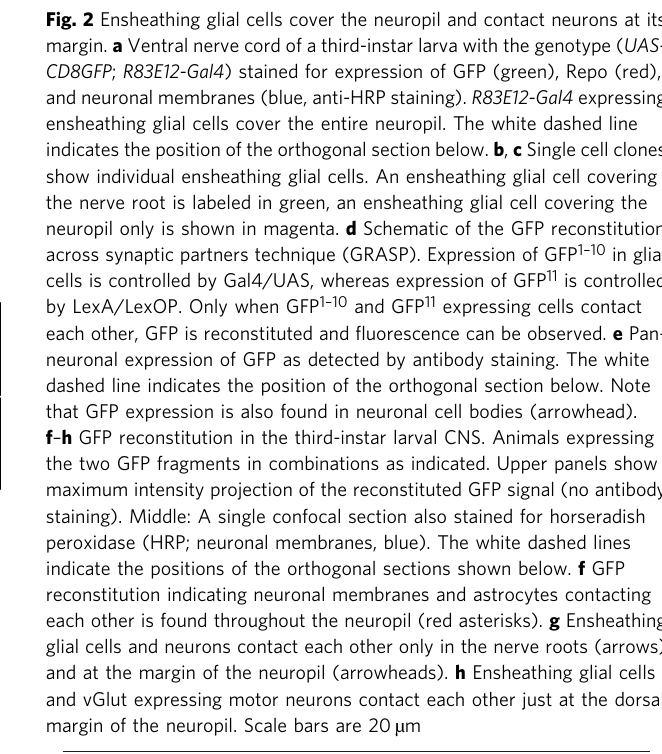
Fig. 2 Ensheathing glial cells cover the neuropil and contact neurons at its margin. a Ventral nerve cord of a third-instar larva with the genotype ( UAS- CD8GFP ; R83E12-Gal4 ) stained for expression of GFP (green), Repo (red), and neuronal membranes (blue, anti-HRP staining). R83E12-Gal4 expressing ensheathing glial cells cover the entire neuropil. The white dashed line indicates the position of the orthogonal section below. b , c Single cell clones show individual ensheathing glial cells. An ensheathing glial cell covering the nerve root is labeled in green, an ensheathing glial cell covering the neuropil only is shown in magenta. d Schematic of the GFP reconstitution across synaptic partners technique (GRASP). Expression of GFP 1 – 10 in glial cells is controlled by Gal4/UAS, whereas expression of GFP 11 is controlled by LexA/LexOP. Only when GFP 1 – 10 and GFP 11 expressing cells contact each other, GFP is reconstituted and fl uorescence can be observed. e Pan- neuronal expression of GFP as detected by antibody staining. The white dashed line indicates the position of the orthogonal section below. Note that GFP expression is also found in neuronal cell bodies (arrowhead). f – h GFP reconstitution in the third-instar larval CNS. Animals expressing the two GFP fragments in combinations as indicated. Upper panels